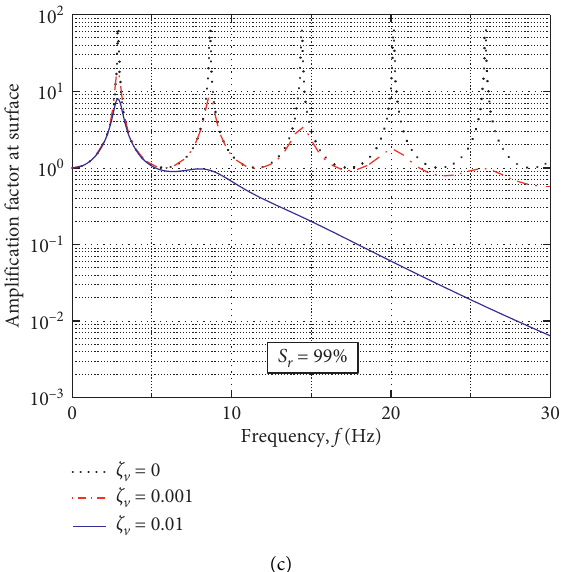
Figure 8: Variation of amplification factor at surface with frequency at three cases of different saturation degrees (vertical motion).